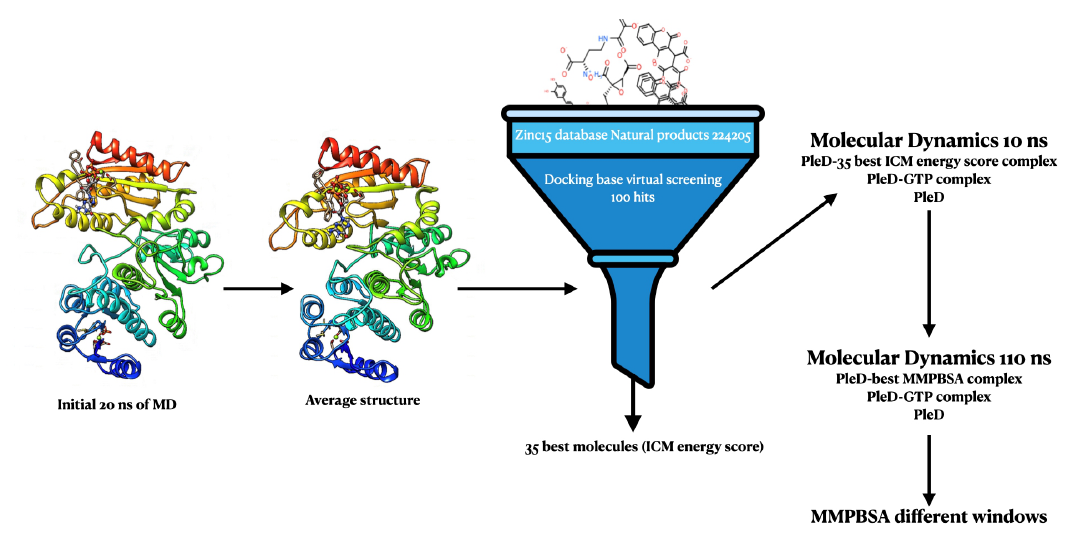
Figure 1. Summary of procedures used for the hit identification. An initial 20 ns of molecular dynamics (MD) was performed with the PleD protein (inactive form) in complex with guanosine-5 (cid:48) -triphosphate (GTP) molecule and Mg 2 + ions, by following the crystal structure of the active form 2V0N to coupling the GTP at the catalytic site. From an equilibrated trajectory starting at 1.2 ns, an average structure was produced using chimera software [26]. A library of about 224,205 natural products compounds was obtained from ZINC15 database. Bond orders, tautomeric forms, stereochemistry, hydrogen atoms, and protonation states were assigned automatically by the ICM package, with default parameters for each compound to prepare the ligands for docking. Ligands were docked using virtual screening scheme from ICM using the PleD protein average structure obtained by the above procedure. The GTP geometric space in the protein was used as a reference for virtual screening (VS) procedure and ICM energy scoring function was used for ranking it. From the 100 hits, 35 with the best ICM energy score were selected for 10 ns of MD simulations. For each molecule, MM/PBSA was computed using 200 frames from the last 2 ns of each MD. Finally, with the best complex (Ligand4–PleD), ranked from MM/PBSA binding free energy, a 110 ns of MD was done. This was also done for the GTP–PleD protein complex and PleD protein. From the above three trajectories, MM/PBSA was computed again at different windows starting from 20 ns until 60 ns using 200 frames for each